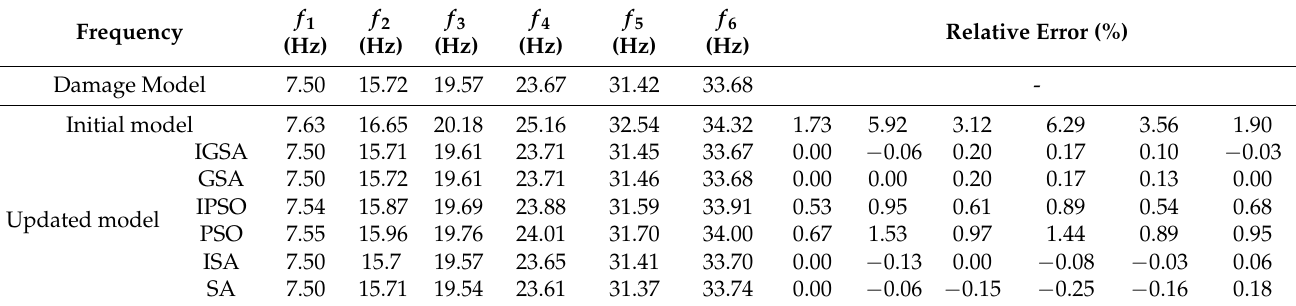
Table 3. The comparison of the first six frequencies obtained from the initial FE model and updated FE model.